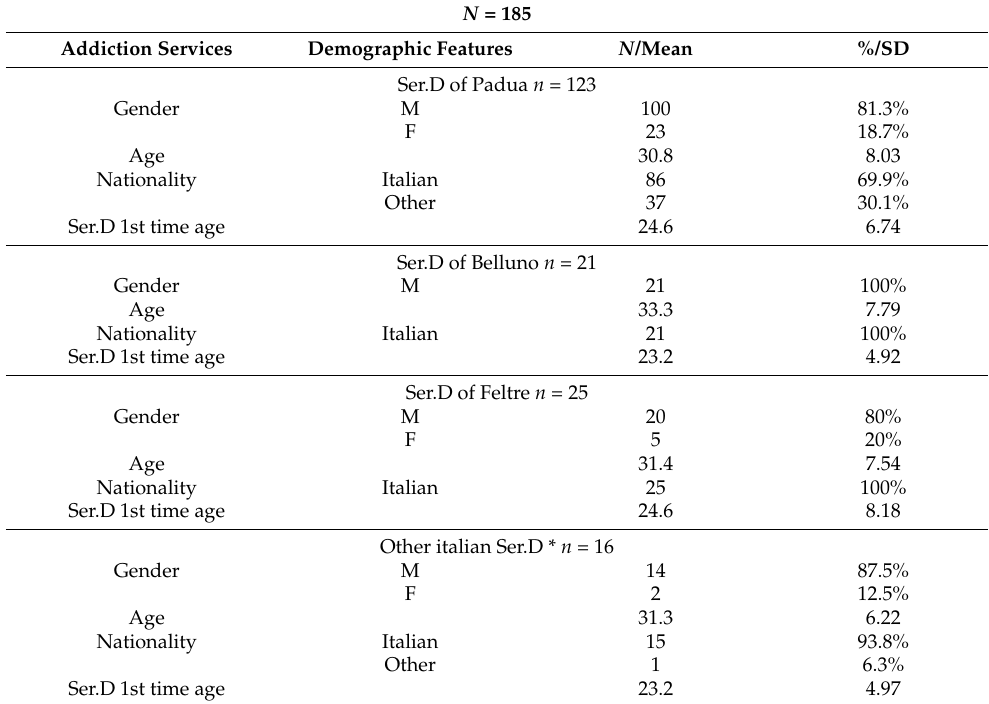
Table 2. Description of the sample including demographic